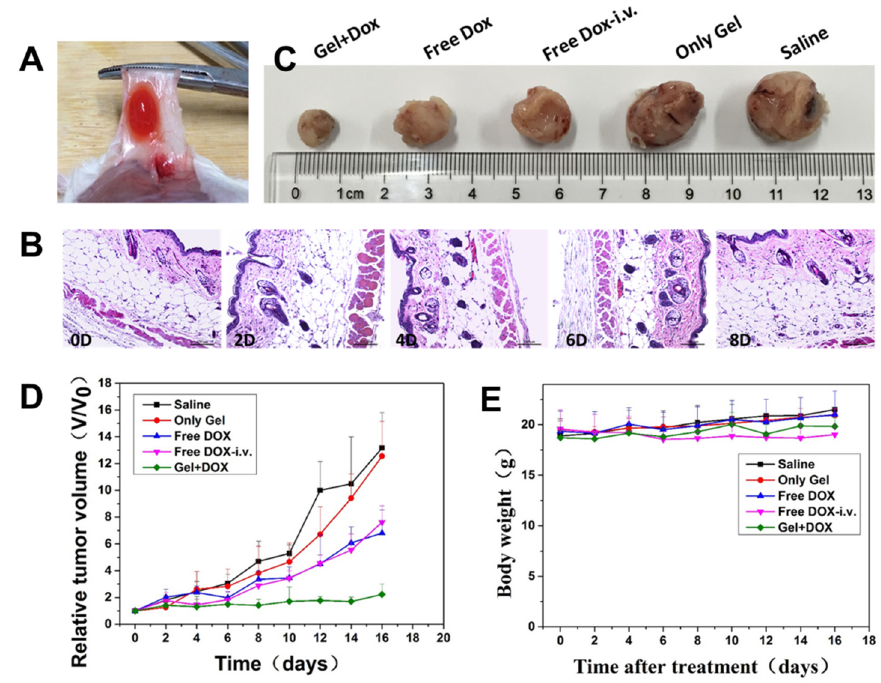
Figure 5. ( A ) In situ DOX@ HPC- g -AA/BSA formation in vivo; ( B ) the in vivo tissue biocompatibility of HPC- g -AA/BSA hydrogels at 10 min (0d), 2, 4, 6, and 8 days. The tissues surrounding the hydrogels were dissected and H&E stained; ( C ) the sizes of tumors obtained after the mice were sacrificed; ( D ) tumor growth inhibition with time; ( E ) the change in body weight of mice during treatments. In vivo antitumor effects of various treatments on BALB/c mice bearing 4T1. The groups were divided into saline, only gel, free DOX-i.v., free DOX, gel + DOX.